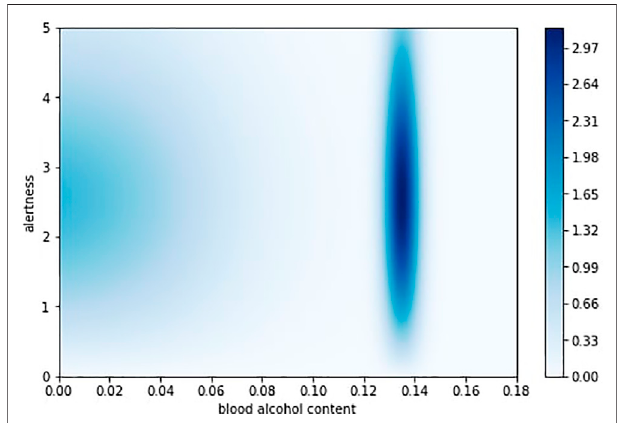
FIGURE 6 | Productivity function in HeartPole.